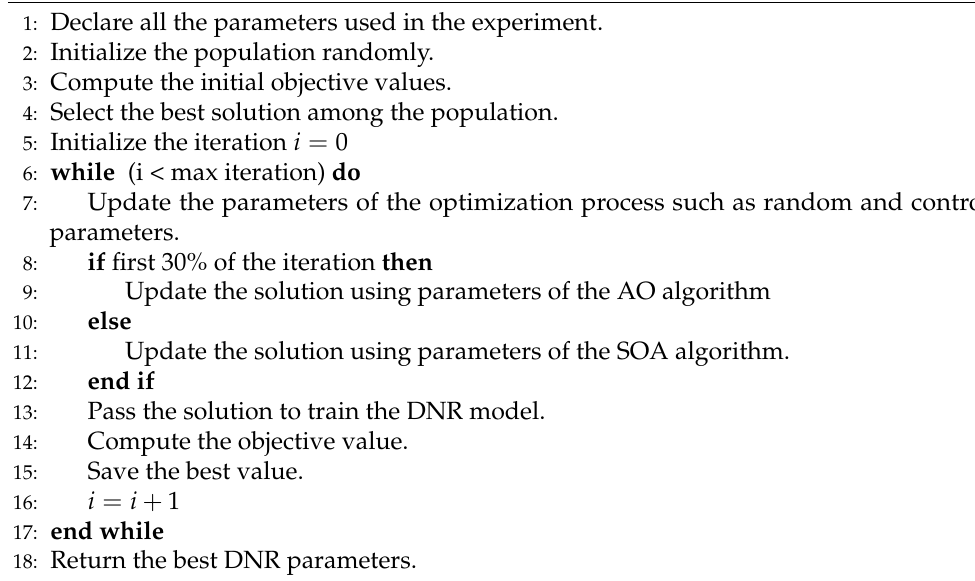
Algorithm 1 SOAAO-DNR